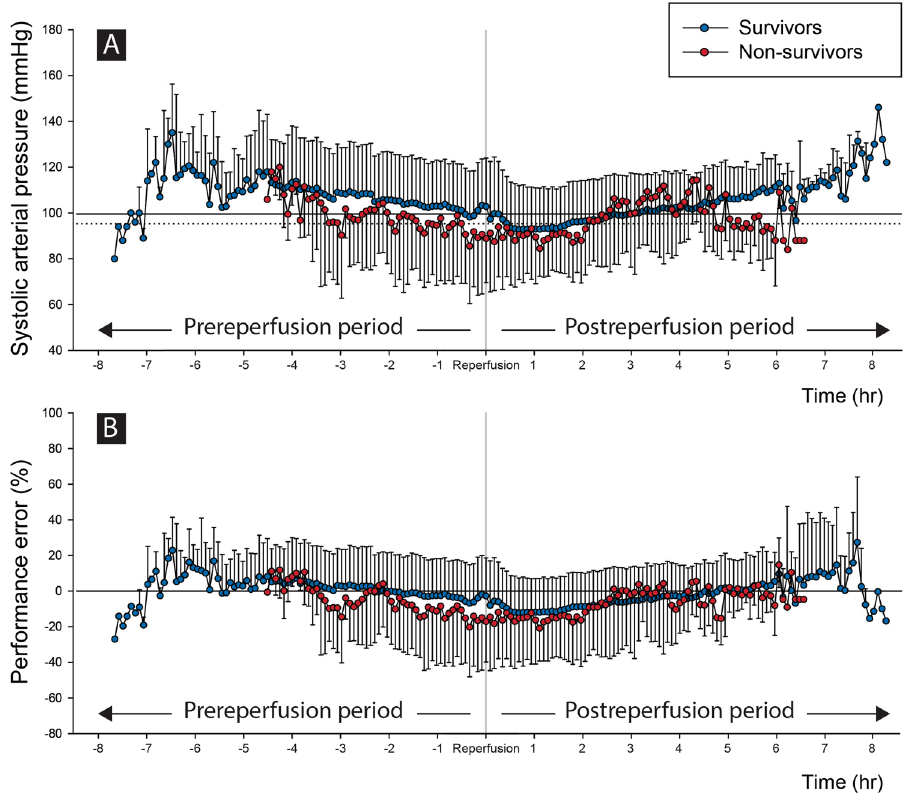
Figure 1. Systolic arterial pressure and performance error during prereperfusion and postreperfusion periods in survivors and non-survivors. Multiple line scatters show the means (dots) and standard deviations (error bars) of survivors and non-survivors. Horizontal lines are averages of intraoperative systolic arterial pressure in survivors (solid line) and non-survivors (dashed line) in Fig. 1A. The graphs start from the time of reperfusion then go towards the start or end of surgery, thus both ends of plot involves only a small number of patients. On average, systolic arterial pressures are a well-maintained around the average systolic arterial pressure in both the survivors and non-survivors during surgery (Fig. 1A). However, performance errors of non-survivors are more deviated and fluctuate above and below the target 0% level, compared to those of survivors (Fig.